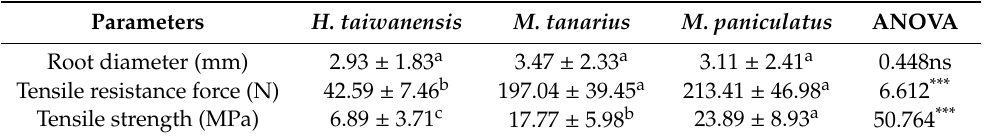
Table 8. Means ± standard deviations of root diameter, root tensile resistance force and root tensile strength for the three species studied and F-values for one-way ANOVA.